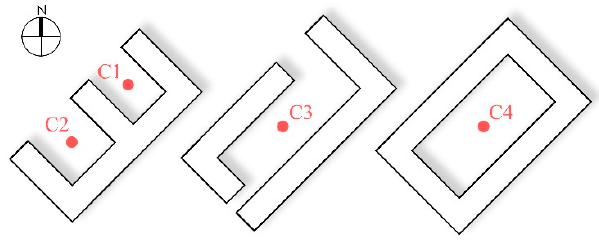
Figure 6. Monitoring sites of courtyards with different sky view factors.